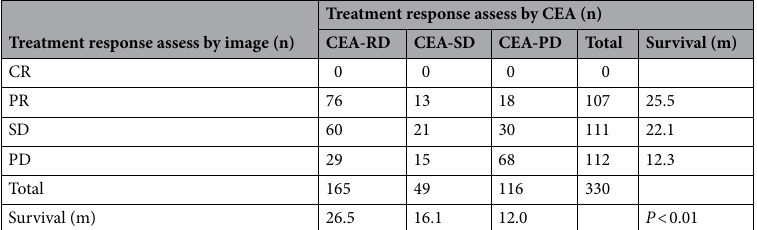
Table 5. Treatment response evaluated by the image and the CEA. CR complete response, PR partial response, SD stable disease, PD progressive disease, CEA-RD response disease by CEA, CEA-SD stable disease by CEA, CEA-PD progressive disease by